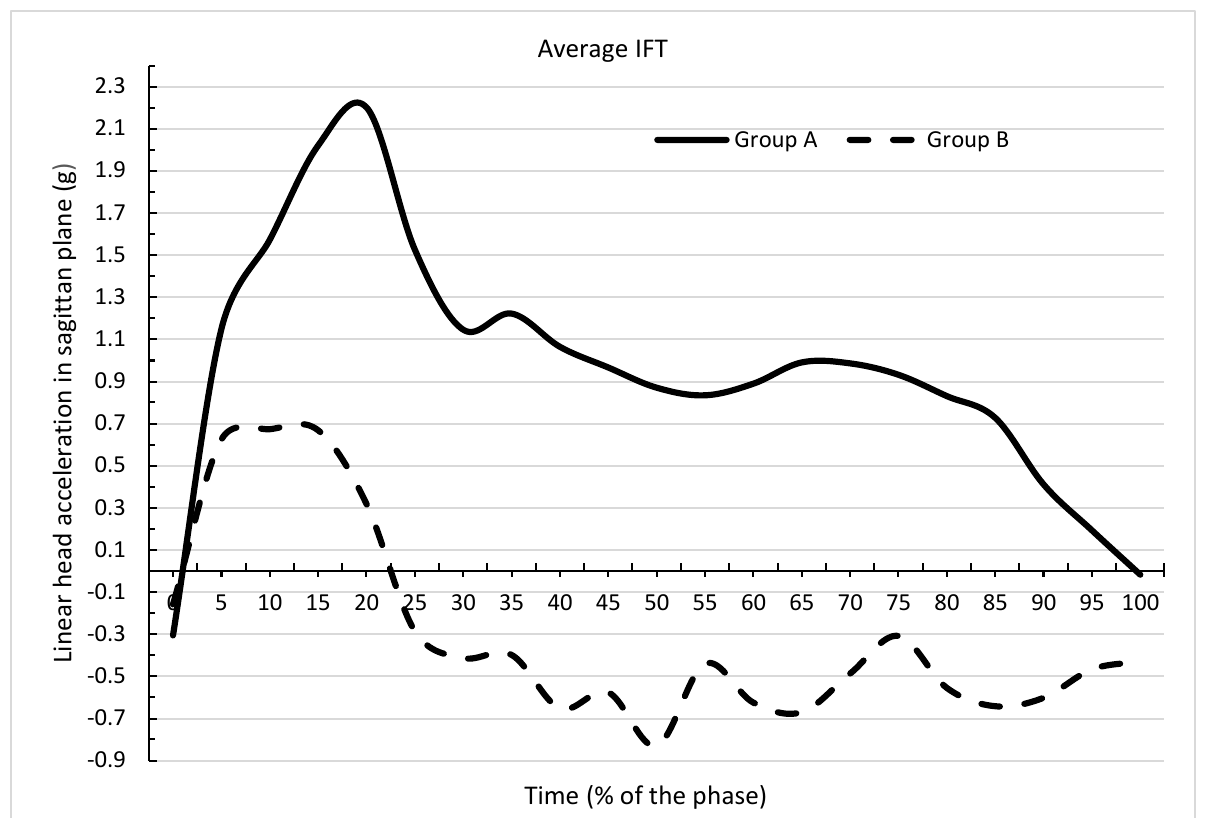
Figure 7. Dependence of mean values of linear head acceleration in the sagittal plane at the time of performing a backward fall in the form of IFT between groups A and B.